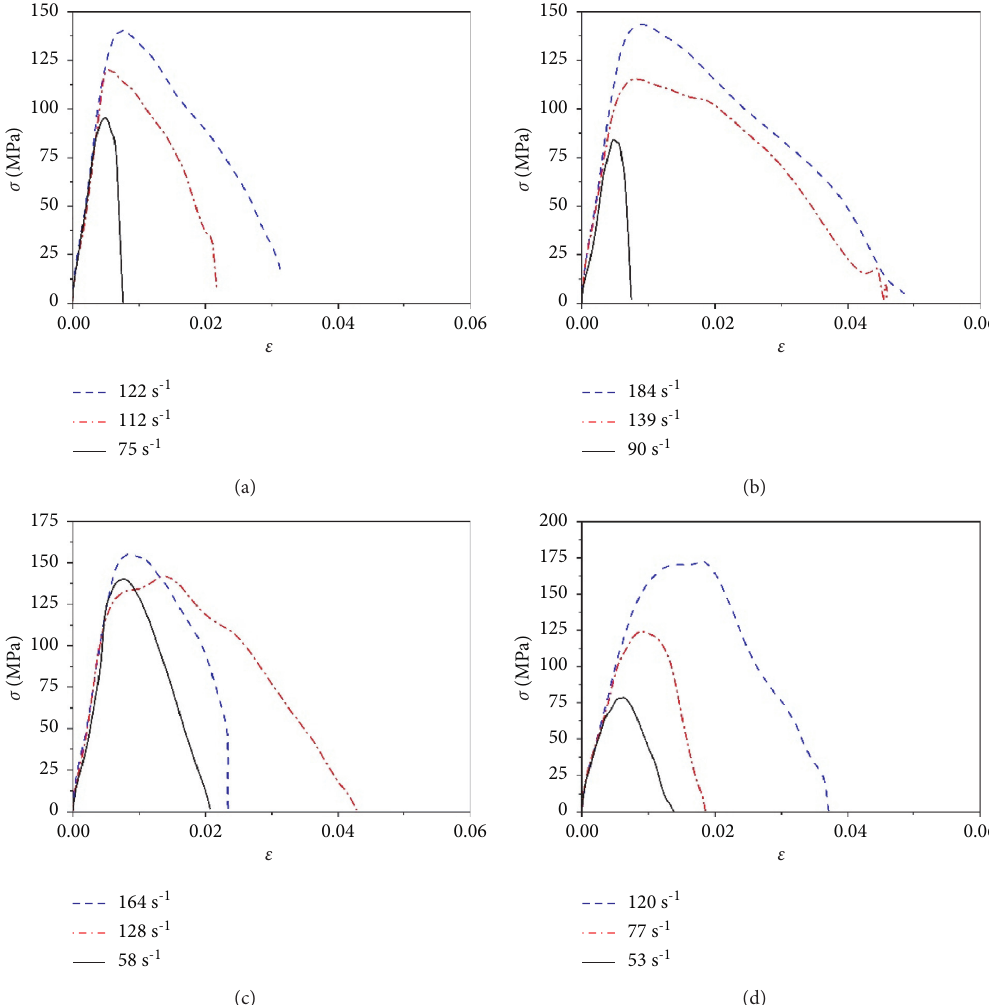
Figure 6: Dynamic compressive stress-strain curves of medium strength SFRSCC: (a) MC-F0.5; (b) MC-F1.0; (c) MC-F1.5; (d)